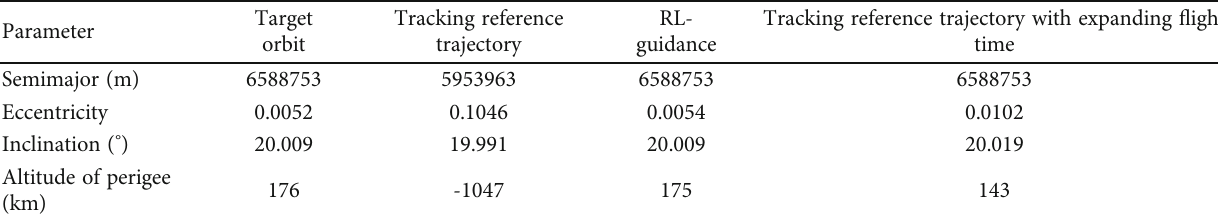
Table 4: Results of experiment